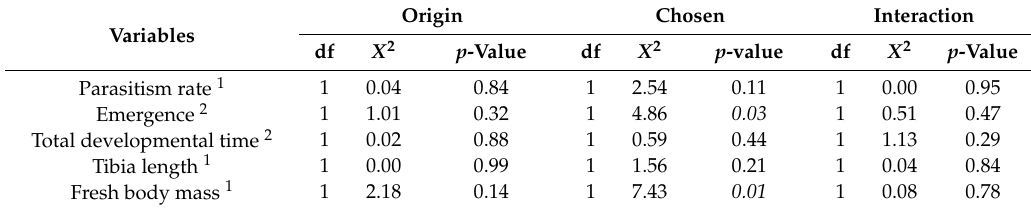
Table 2. Profitability assay. Generalized linear models (GLM) and Generalized linear mixed models (GLMM) showing the e ff ect of the origin host, tested aphid species ( M. persicae and R. Padi ) and the interaction between these two factors on the profitability traits of A. platensis . For each level, the degrees of freedom (df), the Chi square statistical test and the p -value are represented.